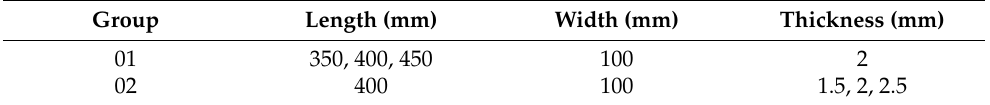
Table 1. Geometric parameters of